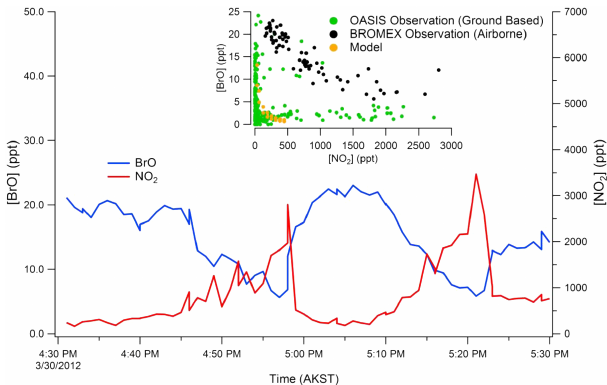
Figure 8. BrO and NO 2 measured mixing ratios via MAX-DOAS during the BROMEX field campaign, near Prudhoe Bay (70 ◦ N, 149 ◦ W), AK at 700m above the surface on 30 March 2012. The insert of the NO 2 versus BrO shows the anti-correlation between the two